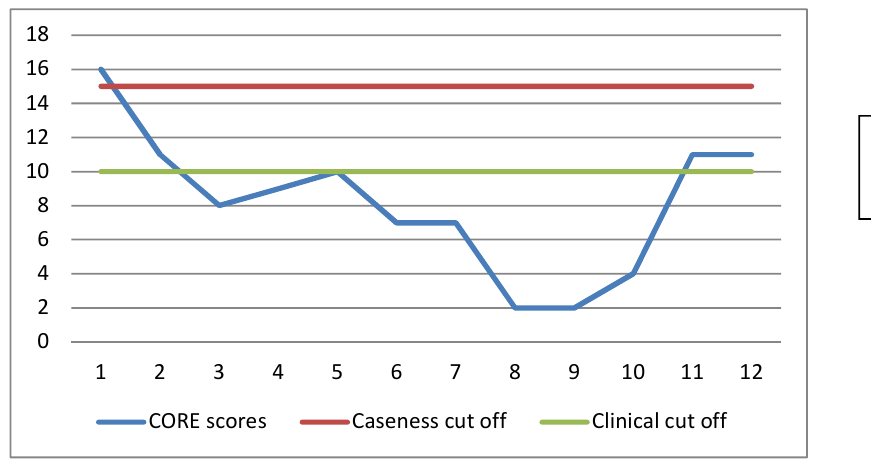
Figure 1: Weekly and Follow-Up CORE-10 scores (clinical significance 10)